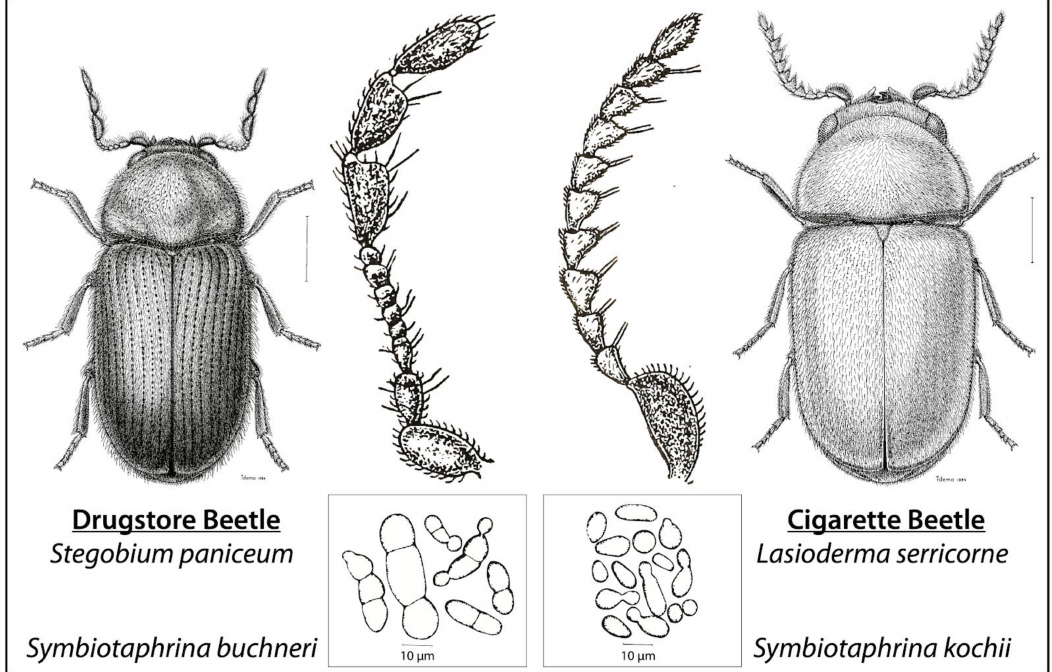
Figure 1. Drugstore and Cigarette beetles and their symbiotic fungi. Scale bar for beetles is 0.5 mm. Figure adapted from Bousquet (1990) [34], Jurzitza (1964) [35], Runner (1919) [36]. Reproduced with permission from Y. Bousquet, Beetles Associated with Stored Products in Canada: An Identification Guide ; published by Canadian Governement Publishing Centre, 1990; illustrated by R.